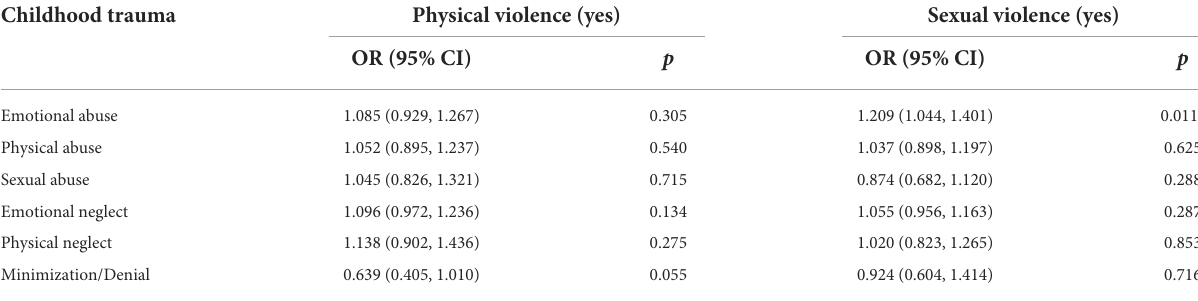
TABLE 3 Simple logistic regression on childhood trauma subdomains in association with physical and sexual